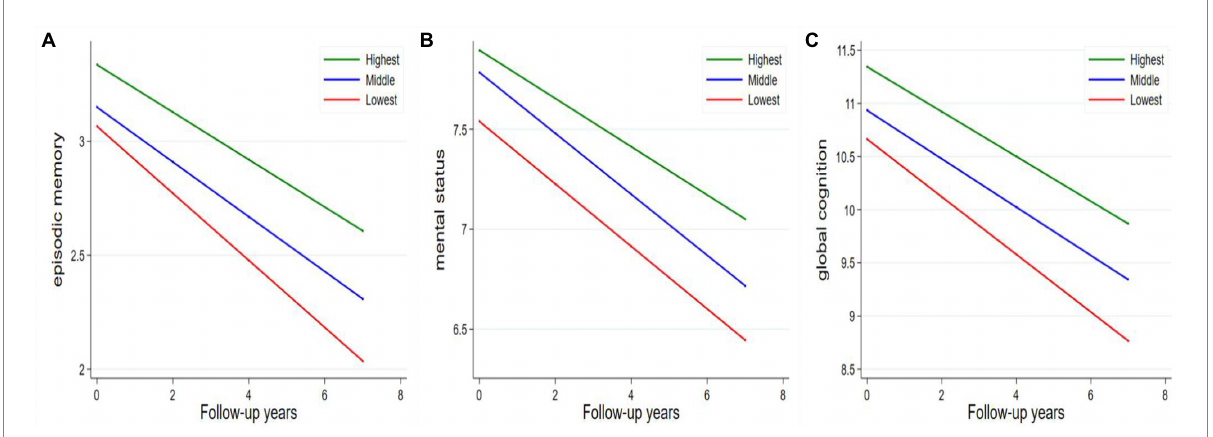
FIGURE 1 Average annual changes in cognitive function according to tertiles of walking speed. (A) Episodic memory; (B) mental status; (C) global cognition. Models were adjusted for age, sex, education, BMI, smoking, alcohol consumption, hypertension, diabetes, stroke, heart disease, lung disease, and follow-up